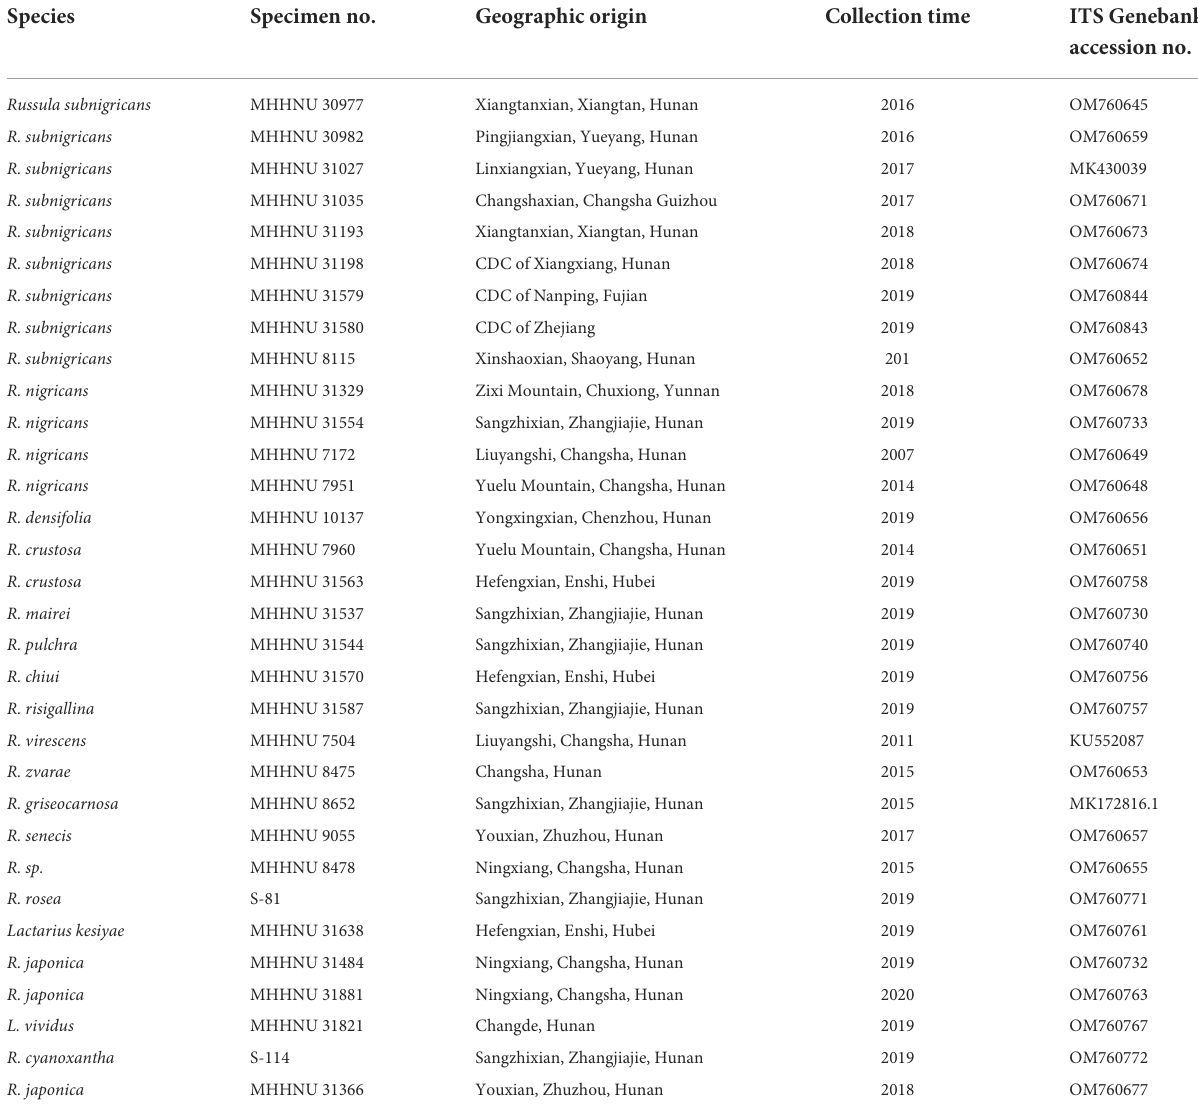
TABLE 1 Mushroom samples used in this study and their related information. Species Specimen no. Geographic origin Collection time ITS Genebank